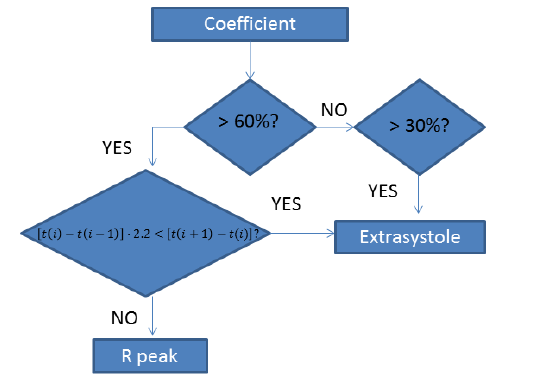
Figure 14. Algorithm for extrasystoles